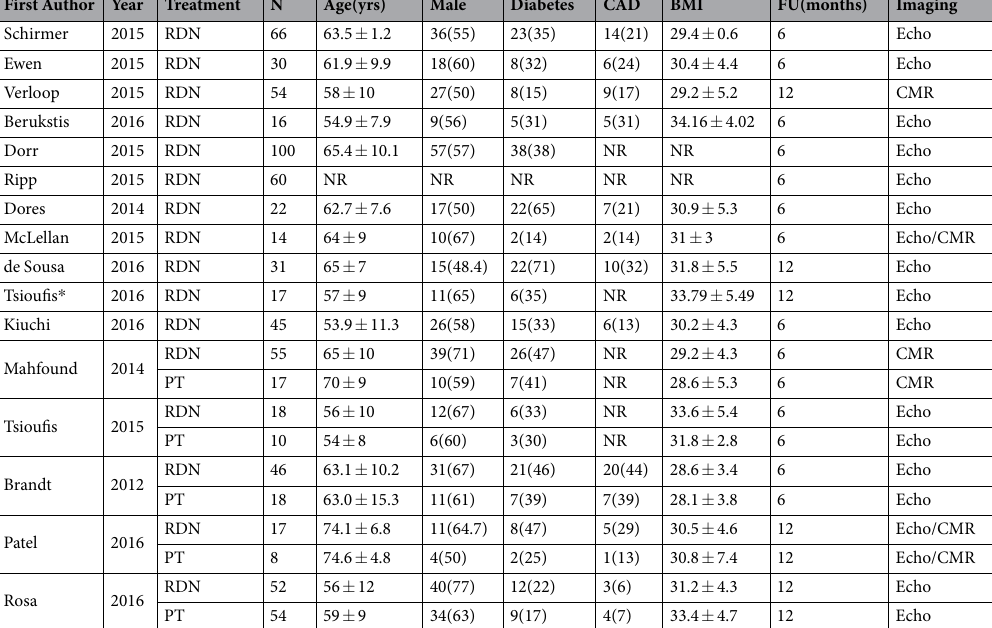
Table 1. Baseline characteristics of included studies and subjects. Values are mean ± SD or n (%). RCT: randomized controlled trial; RDN: renal denervation; PT: pharmaceutical therapy; N: number of patients; CAD: Coronary artery disease; BMI: body mass index (kg/m 2 ). Echo: echocardiography; CMR: cardiac magnetic resonance. NR: not